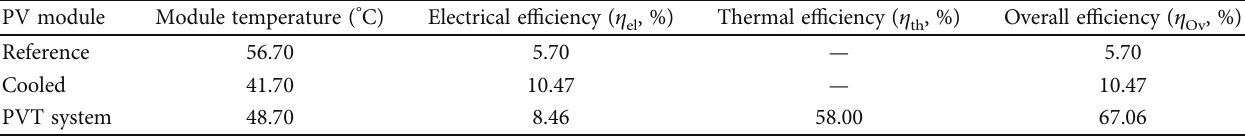
Table 3: Summary of